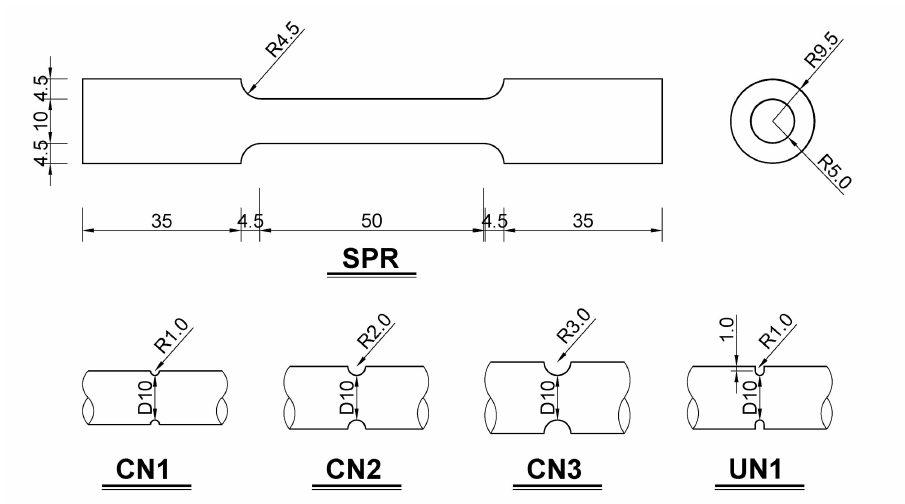
Figure 1. Geometries of the test un-notched and notched specimens (all dimensions are in